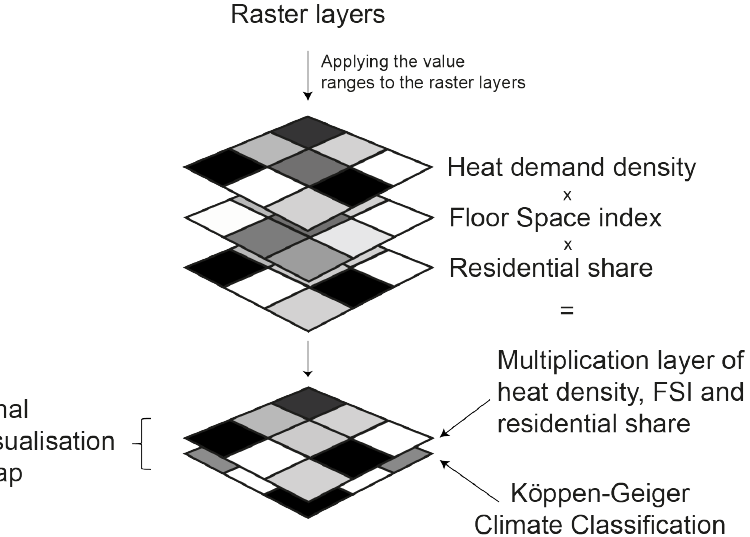
Figure 4. Our methodological approach for the visualisation of the selected parameter combinations on a